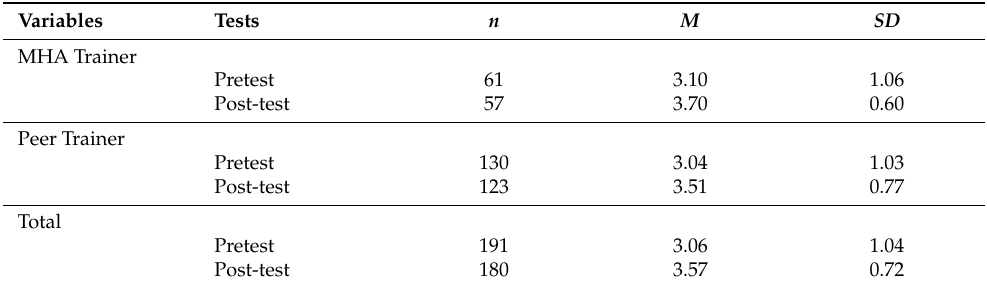
Table 7. Descriptive statistics for knowledge of trauma-informed schools ( n = 371).